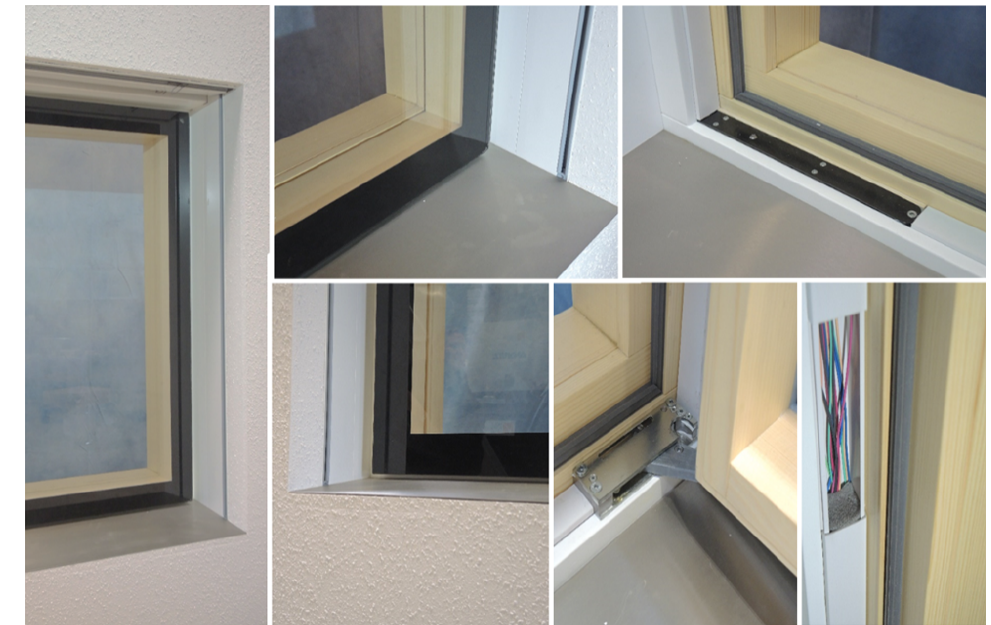
Figure 8. Window prototype A. Different views and perspectives of prototype A.